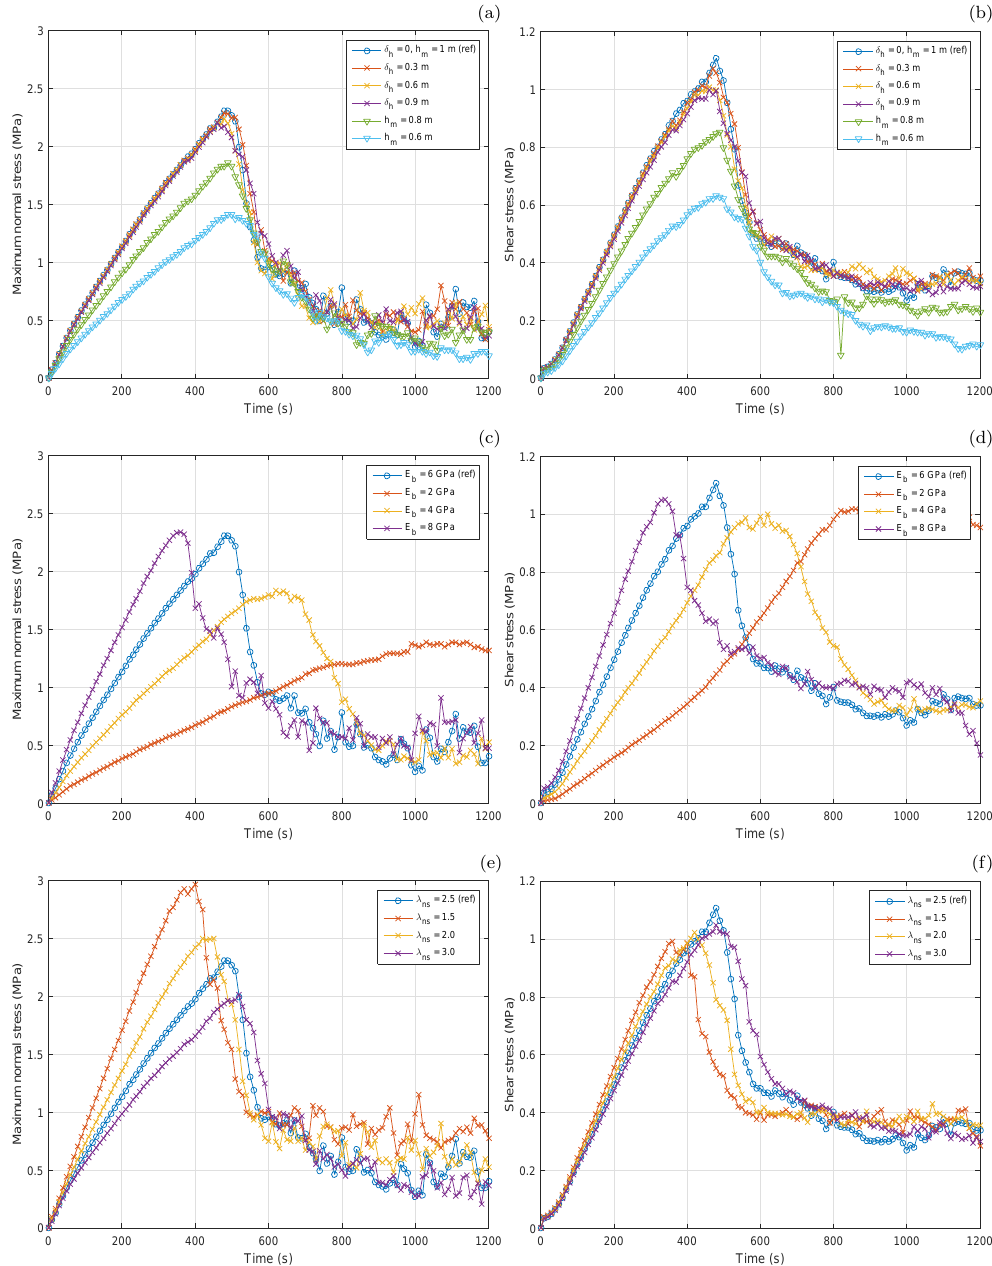
Figure 6. Amplitude of the maximum normal (a, c, e) and shear (b, d, f) stress due to bonded interactions in simulations under uniaxial compressive strain, with variable model